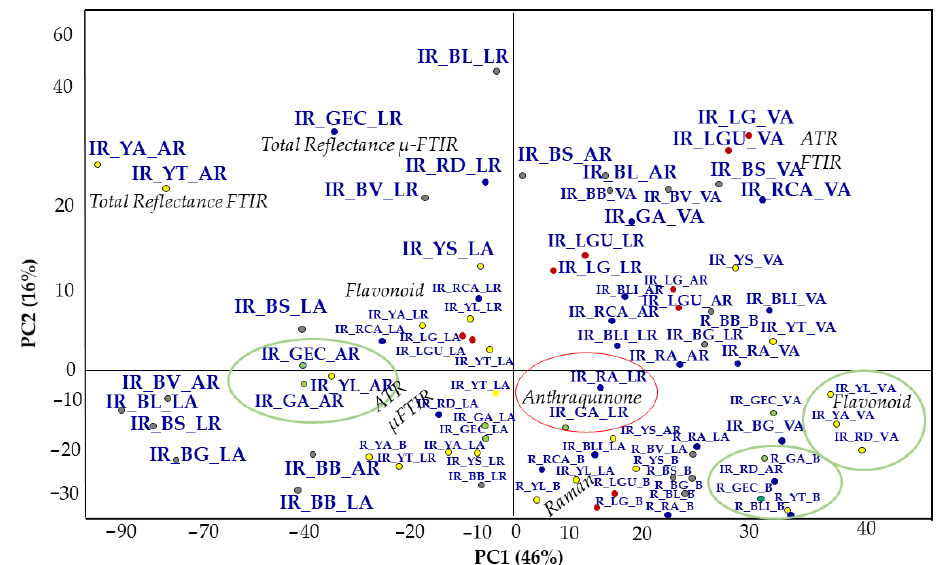
Figure 7. Scores plot (measurements distribution) of the Raman and FT-IR spectra for the organic pigments. The flavonoids are indicated by yellow and green points (wood), and they are grouped by a green circle; the lake pigment are indicated by red points; the anthraquinones are signed by red points and grouped by red circles. The black pigments acquired by LUMOS in ATR are separated along PC2.